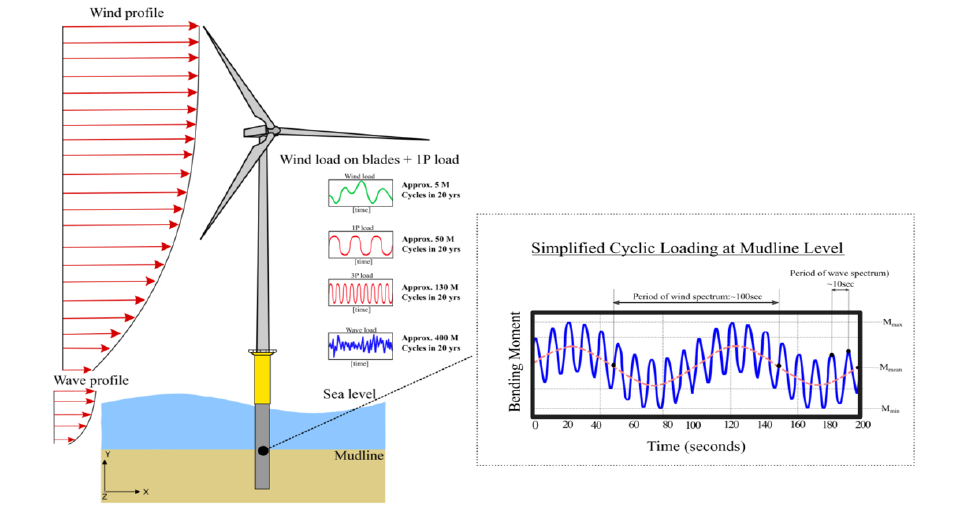
Figure 7. Load complexity with the approximate number of cycles for 20 years assumed